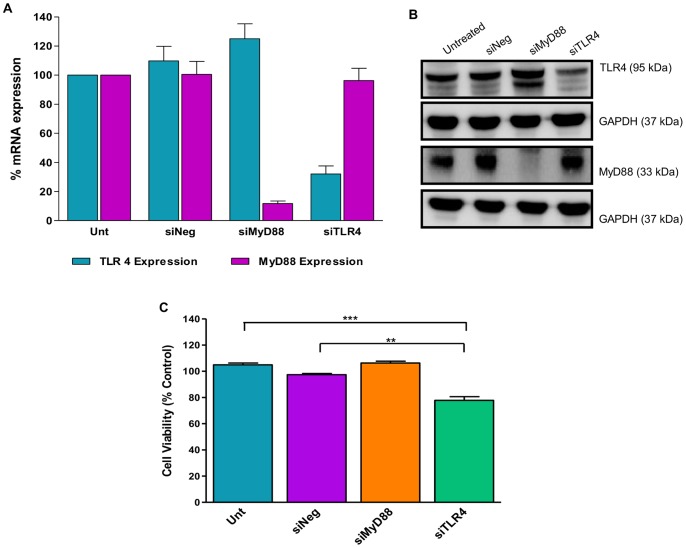
The effect of silencing MyD88 and TLR4 mRNA on the chemoresponsive properties of SKOV-3 cells.SKOV-3 cells were left untransfected (Unt), transfected with negative control siRNA (siNeg), MyD88 targeting siRNA (siMyD88) or TLR4 targeting siRNA (siTLR4). The transfected cells were incubated for 72 hrs before either harvesting for mRNA analysis (A), for protein analysis (B) or treatment with paclitaxel (C). (A) MyD88 and TLR4 mRNA expression levels were evaluated by TaqMan RT-PCR. MyD88 and TLR4 mRNA expression was normalised to that of an endogenous control, B2M, and calibrated to that of untreated cells to establish the relative percentage of mRNA expression (n = 3, mean +SD). (B) MyD88 and TLR4 mRNA expression levels were evaluated by western blot analysis. GAPDH was used as a loading control. (C) Transfected cells were either left untreated, treated with DMSO (vehicle control) or 3.5 nM of paclitaxel (IC25). 48 hrs post treatment, cell viability was assessed by means of the CCK-8 assay. % cell viability rate was calculated by comparing the absorbance values for the vehicle control to the corresponding paclitaxel treated samples. Results are expressed as mean +SD, n = 3; *p<0.05, **p<0.01 (un-paired Student's t-test).